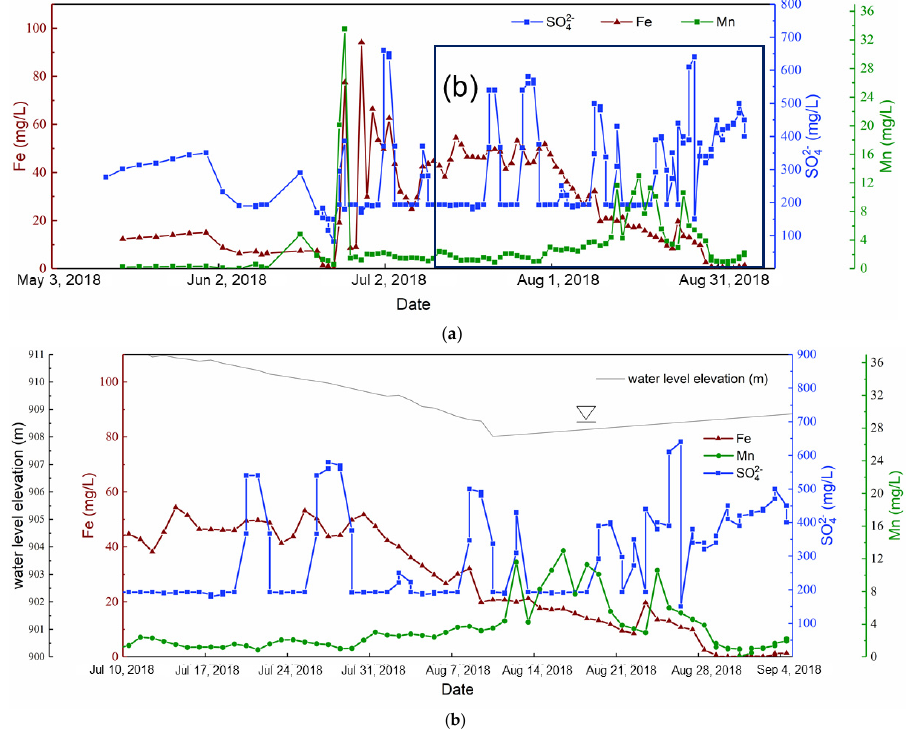
Figure 8. ( a ) Concentration of Fe/Mn/SO 42 − . ( b ) is the part enlarged in ( a